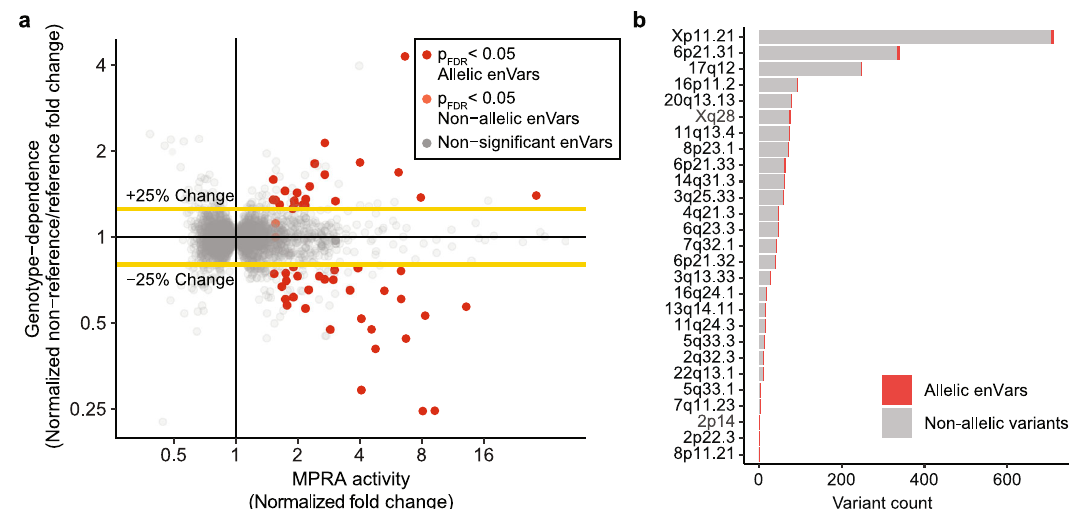
Fig. 3 Regulatory activity of allelic enhancer variants (allelic enVars). a Identi fi cation of allelic enVars. Genotype dependence ( Y -axis) is de fi ned as the normalized fold change of MPRA activity between the non-reference and reference alleles ( n = 3 biological replicates, see “ Methods ” ). MPRA activity ( X - axis) is presented as the maximum normalized fold change of MPRA activity for any allele of the variant. Allelic enVars (red) were de fi ned as variants with a signi fi cant difference in MPRA activity ( p adj < 0.05) between any pair of alleles and at least a 25% change in activity difference (see “ Methods ” ). The p - values were generated by two-sided Student ’ s t -test with Benjamini – Hochberg multiple testing correction. Full results are provided in Supplementary Data 11. b MPRA enhancer activity at the 27 risk loci with at least one allelic enVar. Bar plots indicate the total number of variants at each locus. Variants with allelic enhancer activity (allelic enVars) are shown in red. Variants lacking allelic enhancer activity are shown in